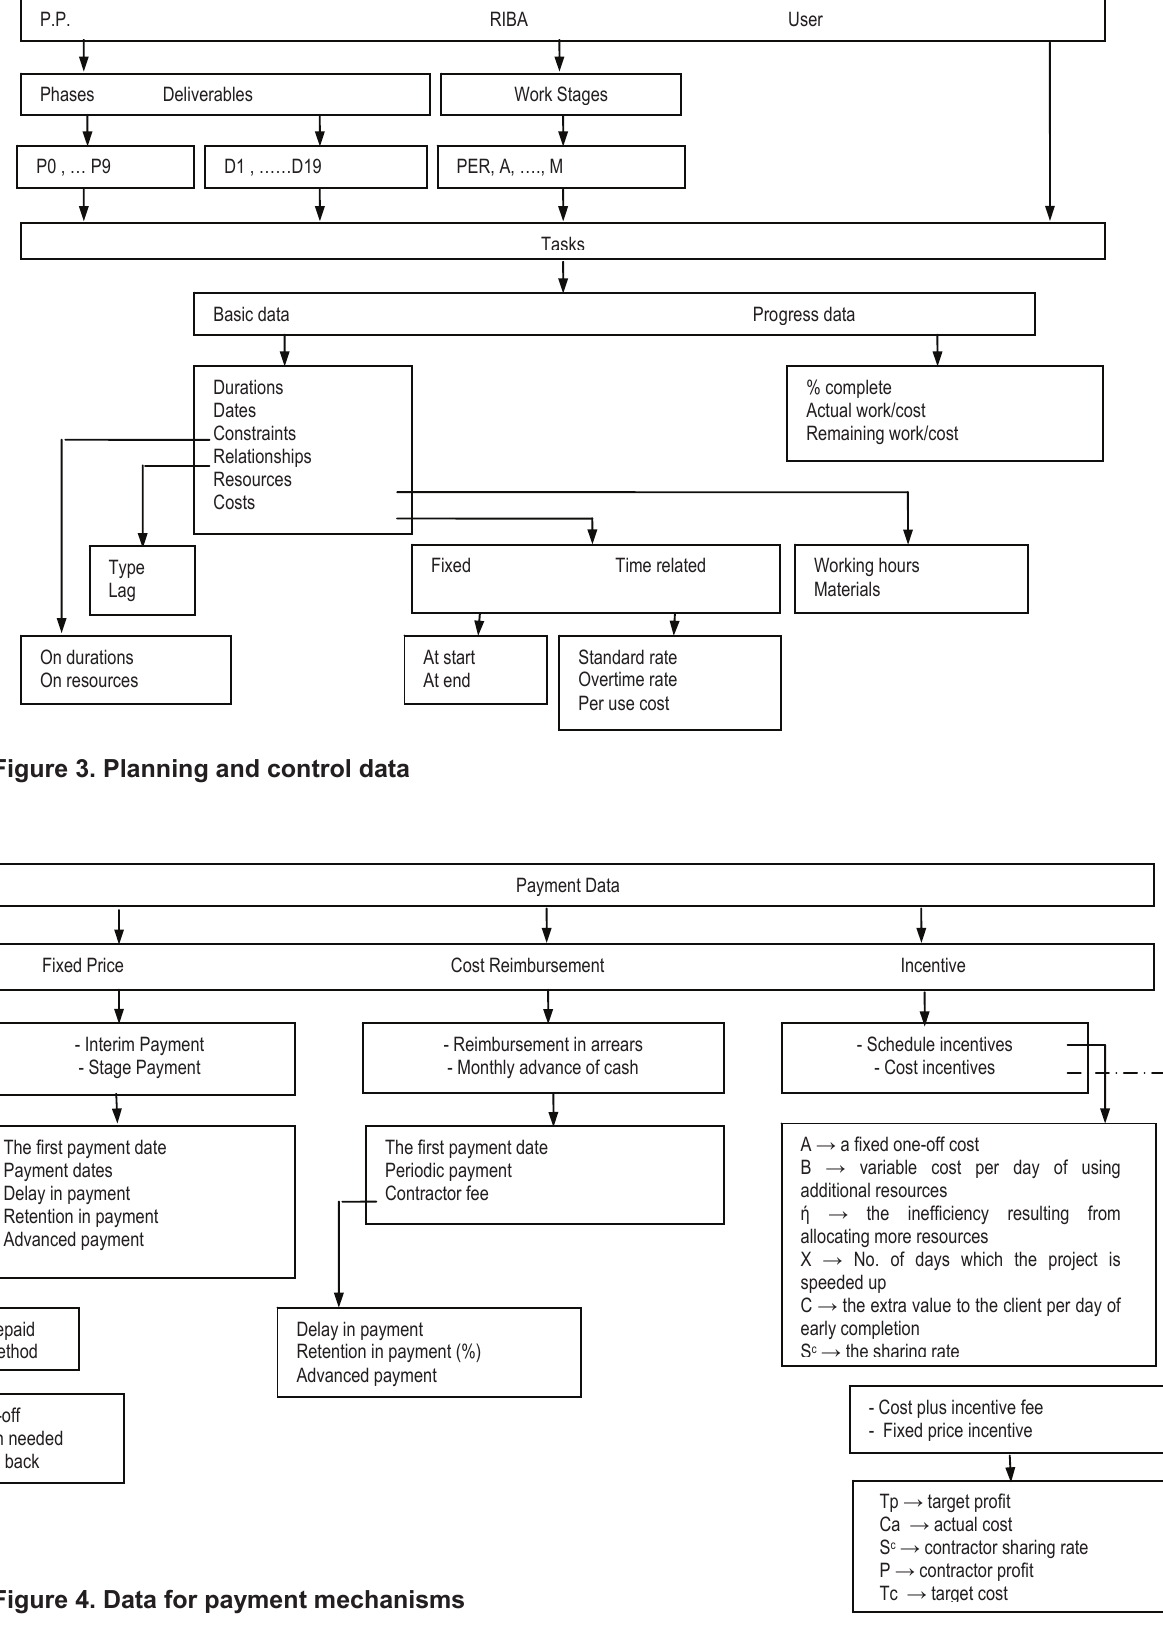
Figure 4. Data for payment